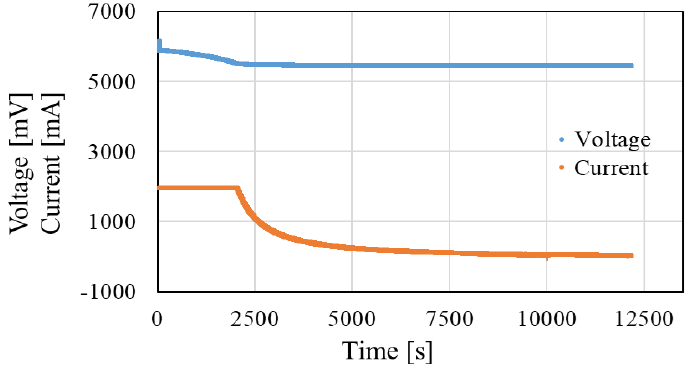
Figure 11. Characteristic of Pb battery during CCCV discharging mode.